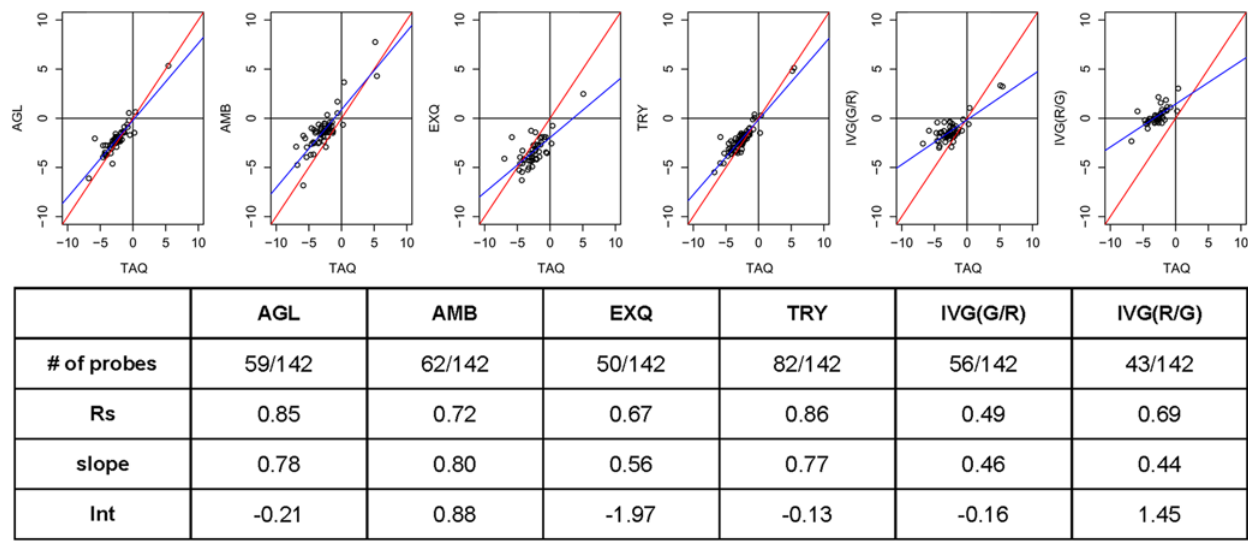
Figure 6. Correlation between microarray and Taqman data. The scatter plots compare the log-ratio differential expression values from each microarray platform relative to values obtained by the Taqman assays. Each point represents a microRNA that was measured on both the microarray and Taqman assays. Only microRNAs that were generally detected in both human liver and prostate were used in the comparisons. Among 142 total microRNAs assayed by the Taqman system, the number of microRNAs analyzed for correlation to the Taqman assays are listed in the table. The red and blue lines shown are the ideal Y=X line, and the regressed line from the scatter plots, respectively. Spearman’s correlation coefficients (Rs), slope and Y intercept of regressed line were shown in the